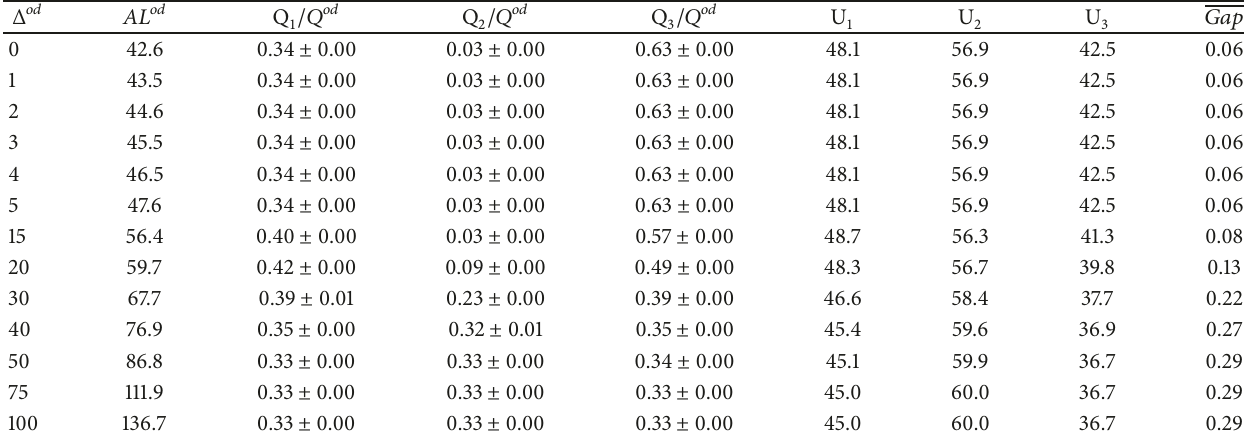
Table 3: BR-SUE route flows for different values of the 𝐴𝐿 𝑜𝑑